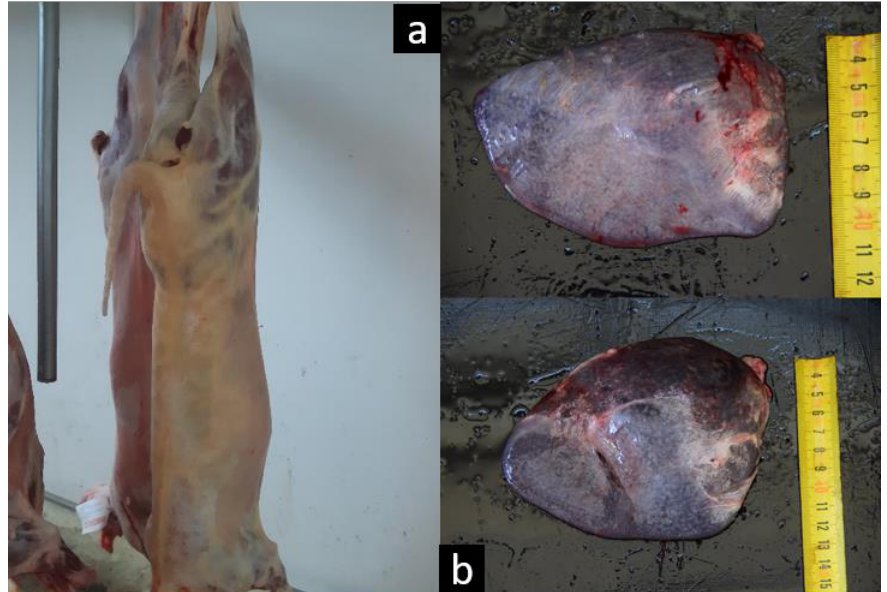
Figure 1. Jaundiced carcass detected at the abattoir ( a ) and spleens from two of the affected animals showing an evident splenomegaly ( b ).